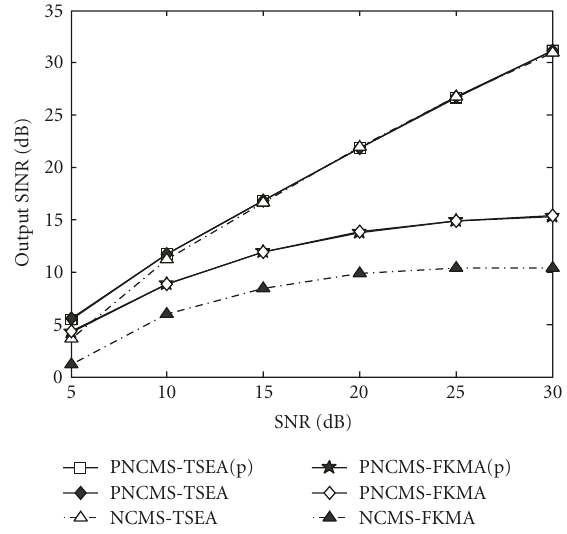
Figure 3: Performance comparison results of Part A (output SINR versus SNR) for A = A 2